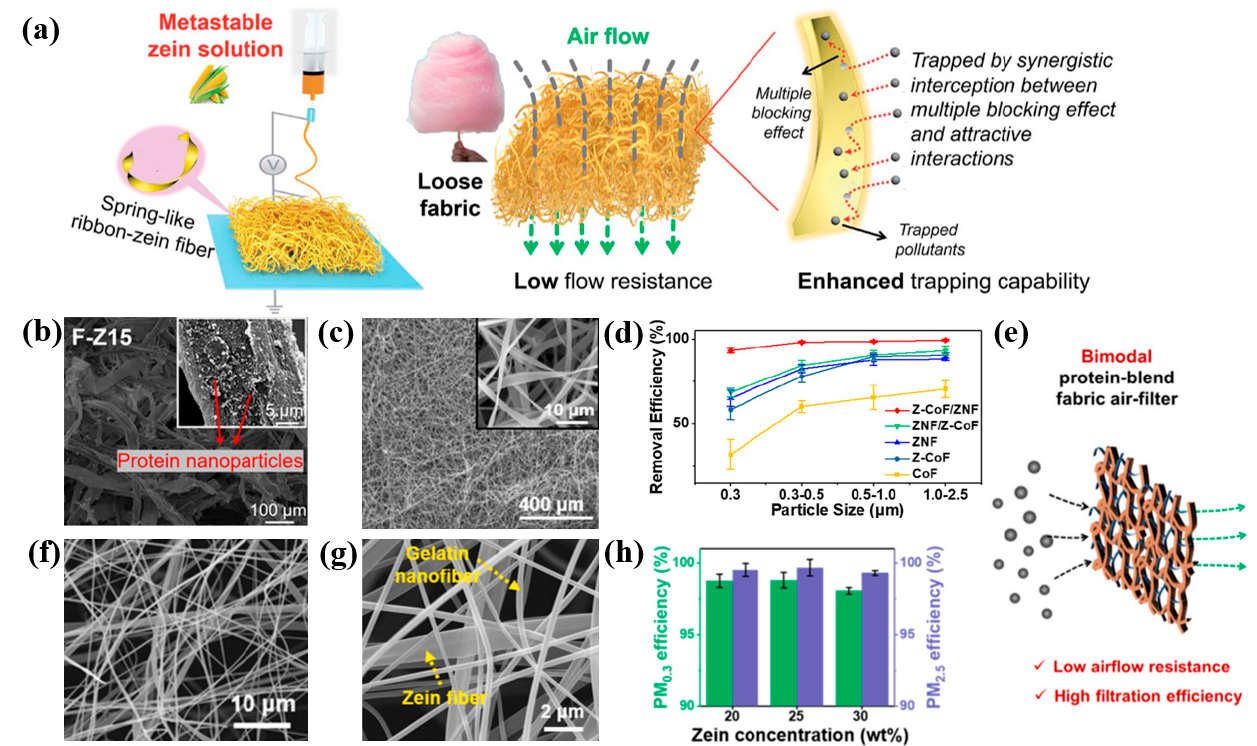
Figure 9. ( a ) Schematic showing metastable zein solution generating cotton-candy-like loose fabric [121] . ( b ) SEM image of F-Z15 air filter [116] . ( c ) SEM image showing the morphology of zein nanofiber. ( d ) Removal efficiencies for particles at different sizes of various air filters [122] . ( e ) Schematic of a bimodal protein-blend fabric. ( f , g ) SEM images of bimodal protein-blend fabric. ( h ) PM 2.5 and PM 0.3 removal efficiencies of the protein-blend fabric air-filters prepared with different concentrations [123] .